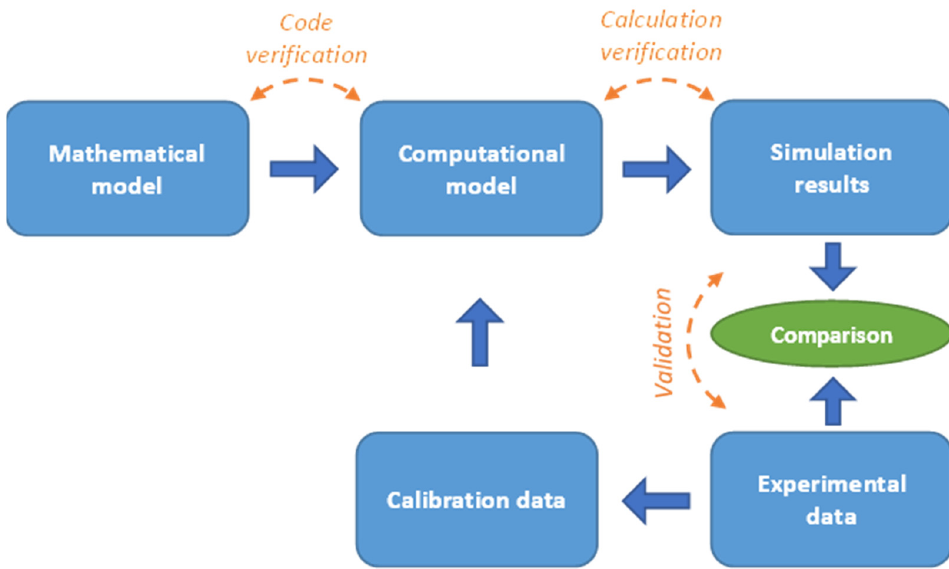
Figure 2. Flowchart for the application, verification, and validation of a finite element analysis (FEA) model.